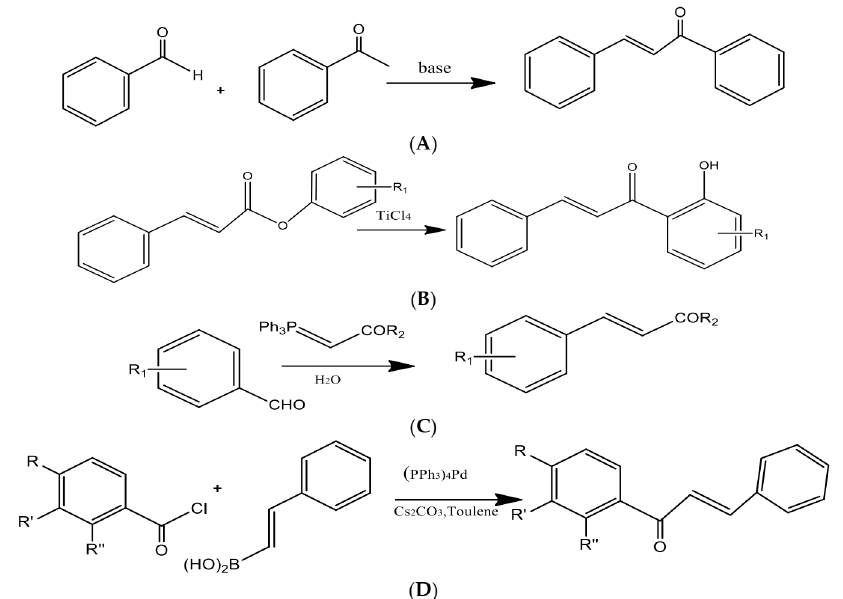
Figure 4. Preparation of chalcones via the ( A ) Claisen–Schmidt condensation, ( B ) Photo-Fries rear- rangement, ( C ) Wittig reaction, and ( D ) Suzuki